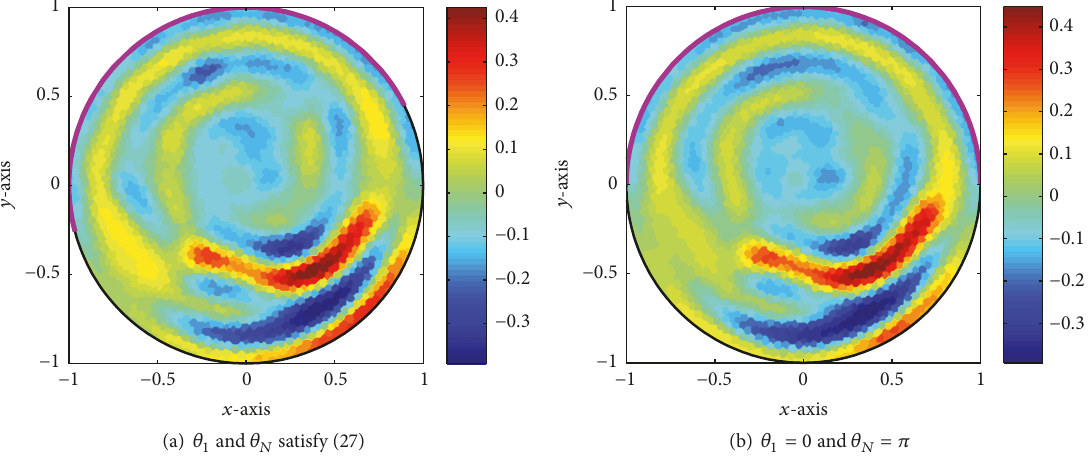
Figure 6: Map of E ( z ;𝐹) for when inhomogeneity is Γ 2 .